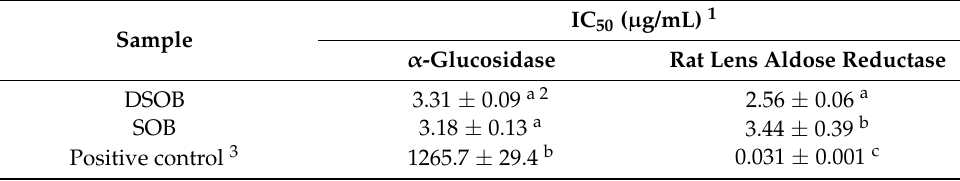
Figure 1. The inhibitory effects of defatted seeds of Oenothera biennis (DSOB) and seeds of Oenothera biennis (SOB) on α -glucosidase ( A ) and rat lens aldose reductase ( B ). Data in the bar graph with different letters are significantly different from each other ( p < 0.05). Table 1. The IC 50 values of defatted seeds of Oenothera biennis (DSOB) and seeds of Oenothera biennis (SOB).